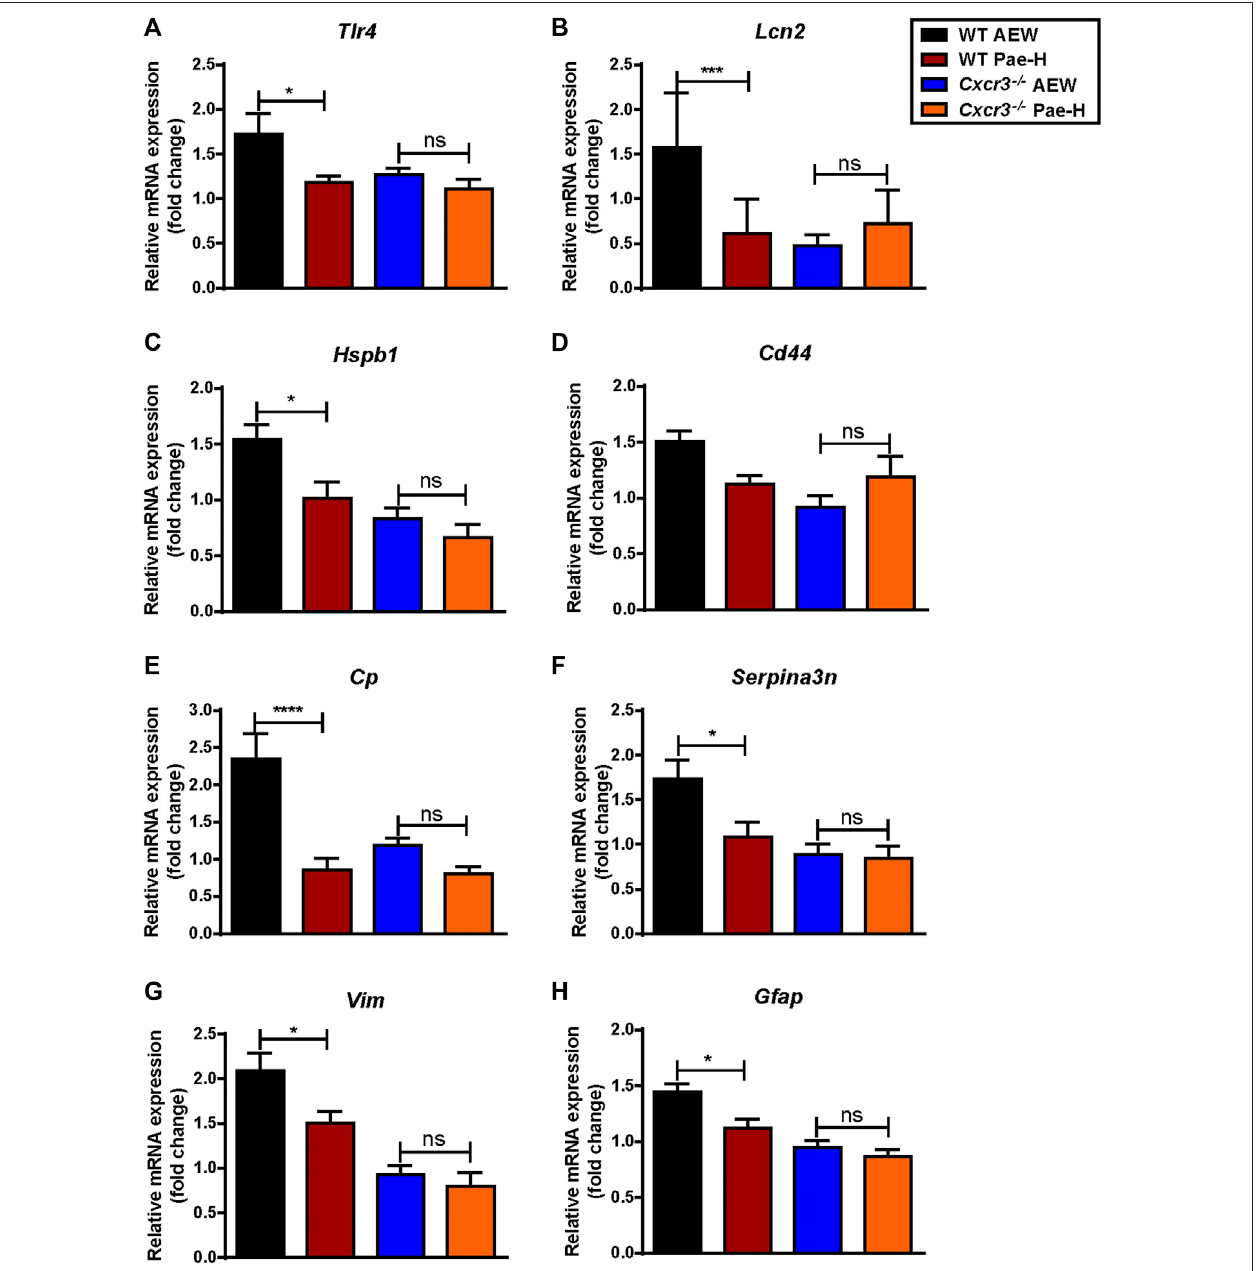
FIGURE 9 | The effects of paeonol on astrocyte activity-dependent genes in WT mice and Cxcr3 − / − mice. (A – H) The effects of paeonol on mRNA levels of genes related to reactive astrocytes in WT and Cxcr3 − / − mice ( n (cid:1) 5 – 9 each group). Data were expressed as mean ± SEM. p p < 0.05, pp p < 0.01, ppp p < 0.001, ppp p < 0.0001, compared to the WT-AEW model